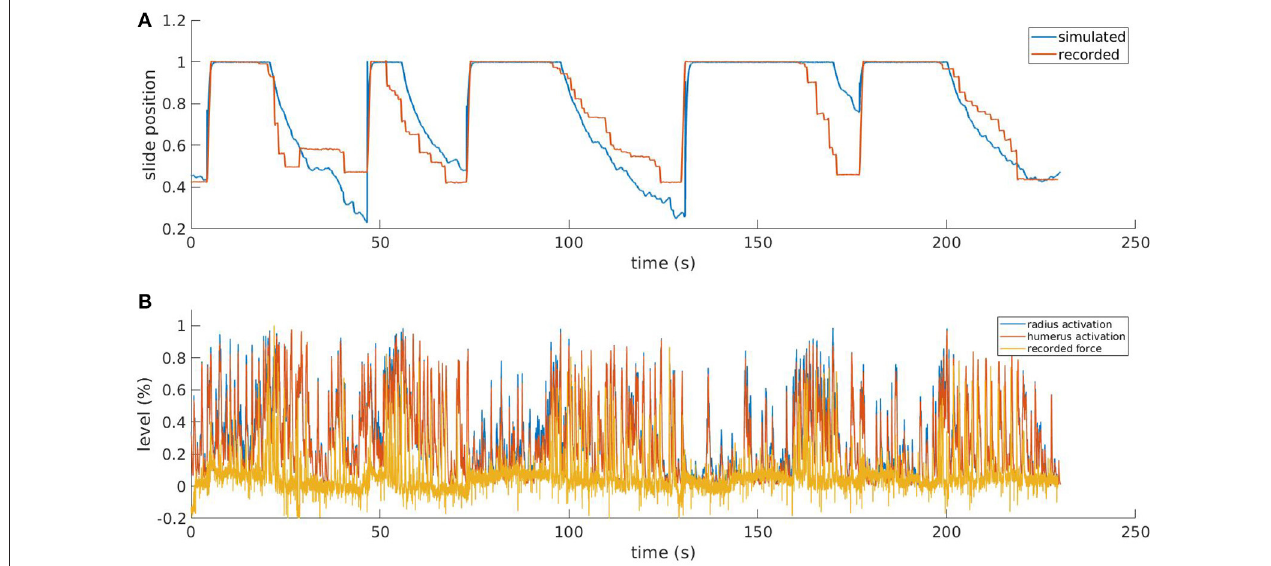
FIGURE 8 | Results from the simulated pulling experiment. Comparison between the simulated slide position and the one recorded in the in-vivo experiment (A) and comparison between simulated muscle activation levels and force applied to the physical slide (B) . To increase the readability of the bottom figure, an upper peak envelope was applied to the